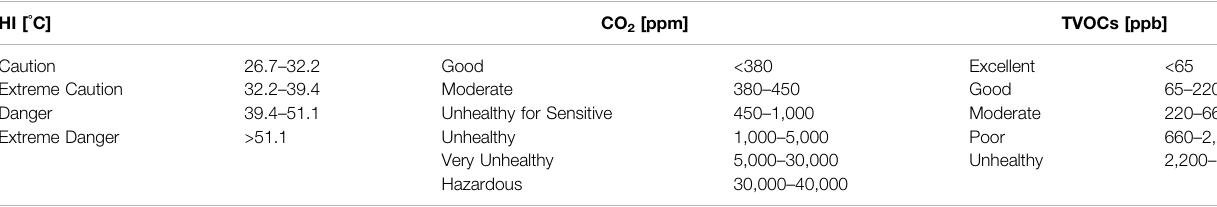
TABLE 1 | IEQ Classi fi cation based on Heat Index and measured